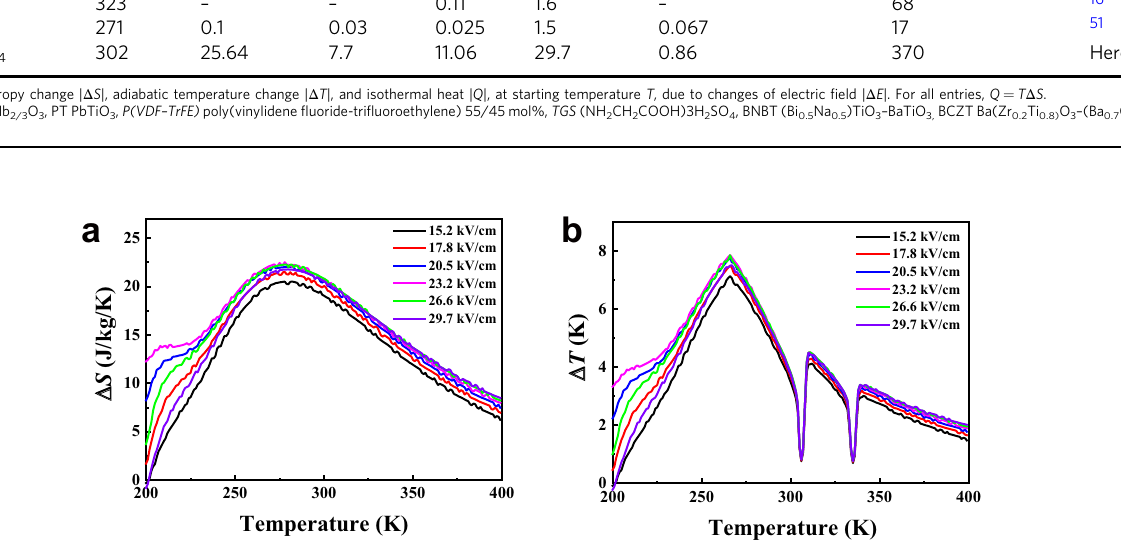
Fig. 5 Ab initio calculated EC performance. The EC entropy change Δ S ( a ) and the EC temperature change Δ T ( b ) for 1 under different electric fi eld